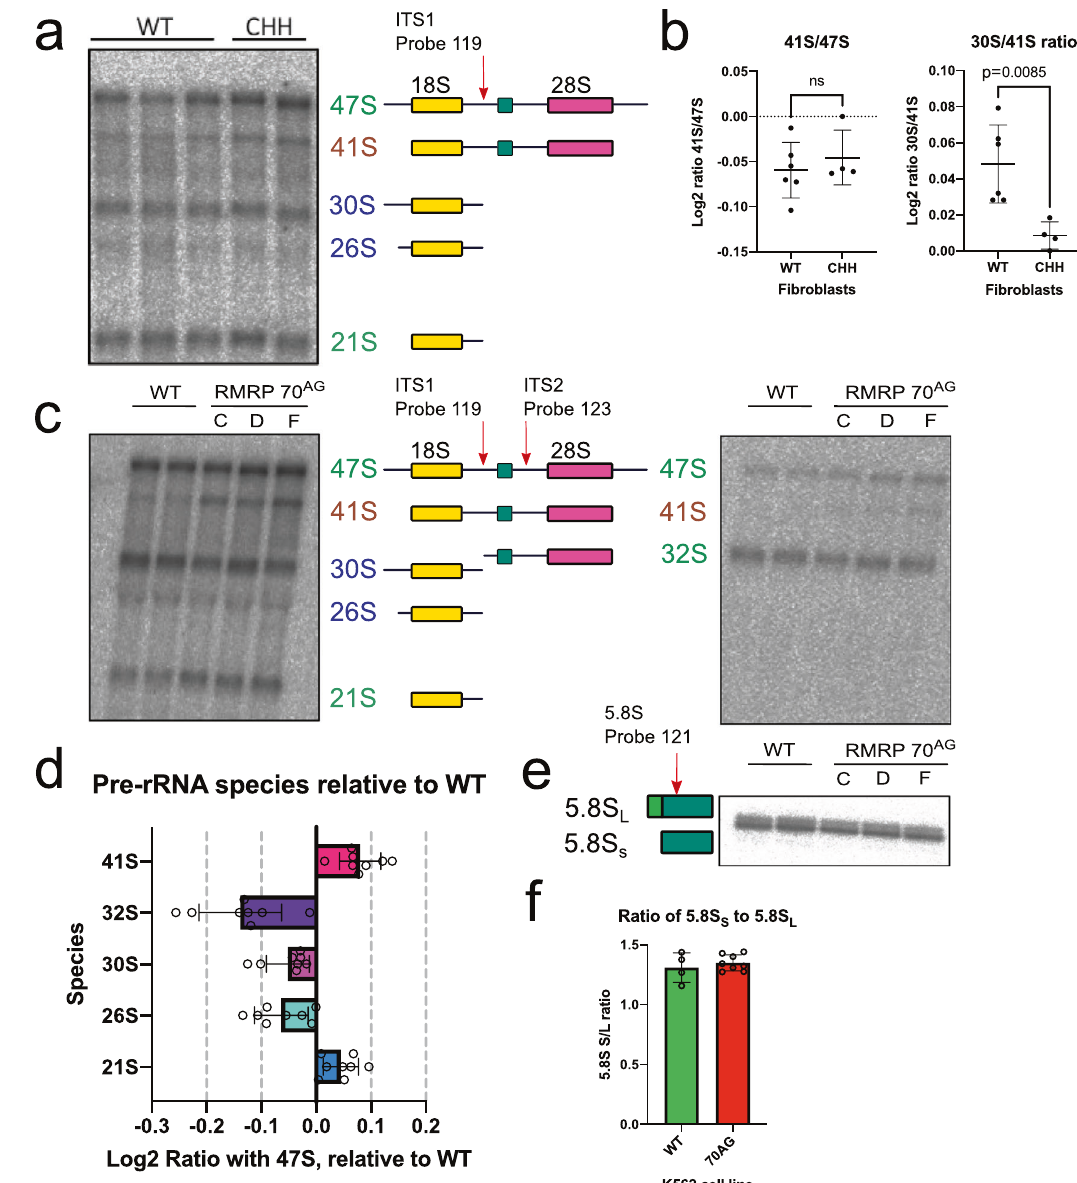
Fig. 2 Mutations associated with Cartilage Hair Hypoplasia impair rRNA processing. a Northern blot using ITS1 probe (probe 119) to detect pre-rRNA species in RNA extracted from CHH or healthy control (WT) fi broblasts. Pre-rRNA species indicated in green are present in both Pathway 1 and Pathway 2. 41 S in brown is a Pathway 1 intermediate, and those in blue are Pathway 2 species. b Quanti fi cation of relative abundance of 41 S to 47 S, and 30 S to 41 S, from northern blots as illustrated in a . Each dot represents an independent sample (total of 6 WT and 4 CHH samples; mean + / − SD). Includes samples processed in two independent northern blotting experiments. Indicated p value for 30/41 S derived from two-tailed t test ( t = 3.463, df = 8). c Northern blot using probes against ITS1 (left; probe 119) and ITS2 (right; probe 123), to detect pre-rRNA in parental K562 cells, or CRISPR-generated clones of K562 with a 70 AG mutation in RMRP . C, D, and F represent cell lines derived from independent CRISPR clones. d Quanti fi cation of pre-rRNA species from WT and 70 AG K562 cells. The intensity of bands for each indicated species were fi rst normalized to the 47 S band in that lane. Values from WT cells were then subtracted from mutant values. Includes data from three independent experiments (mean + / − SD). e Northern blot with probe against 5.8 S rRNA, showing the short (5.8S S ) and long (5.8S L ) form of these species in indicated cell lines. f Quanti fi cation of ratio between 5.8S S and 5.8S L, determined from northern blots illustrated in e . Includes data from three independent rounds of RNA extraction, run on two separate gels, including total of 4 wild type and 8 mutant samples (mean + / − SD). Source data are provided as a Source Data fi